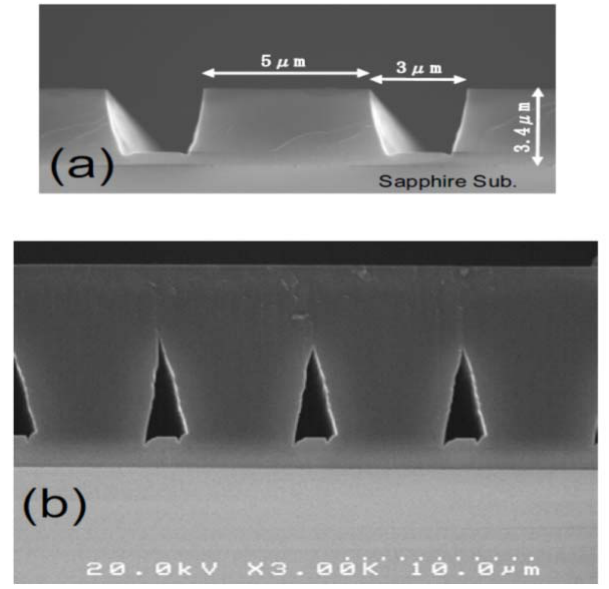
Figure 7. Cross-sectional high-resolution scanning electron microscope (HR-SEM) images of (a) an AlN stripe structure and (b) an ELO-ALN template